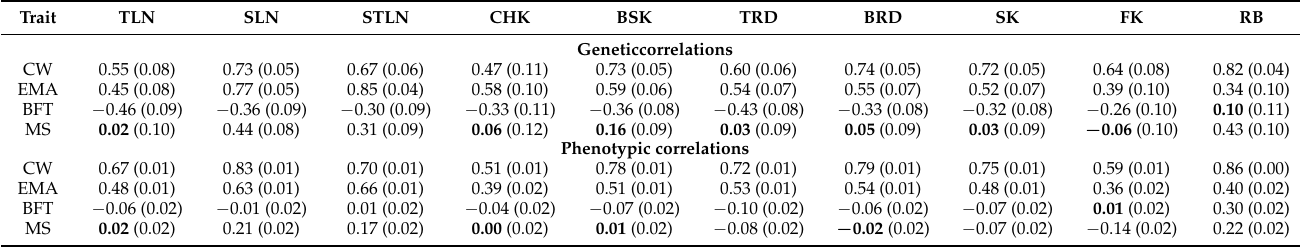
Table 4. Estimates of genetic and phenotypic correlations (SE in parentheses) among the primal cut yields and carcass traits in Hanwoo